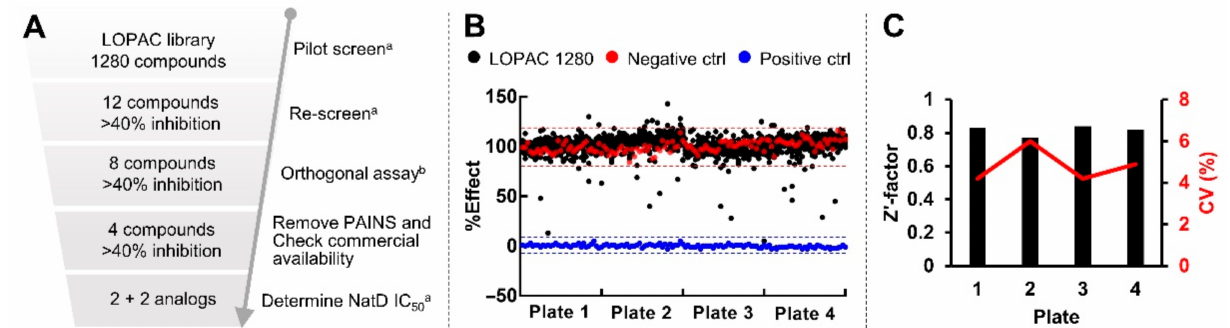
Figure 5. Pilot screen summary in the Library of Pharmaceutically Active Compounds (LOPAC) library. ( A ) HTS screening flowchart. a Performed by fluorescence assay. b Performed by MALDI-MS assay ( B ) Screening results. Red and blue dash lines represent 3 standard deviations from the mean of negative and positive controls, respectively. ( C ) Z (cid:48) -factors and %CV of each plate in the pilot